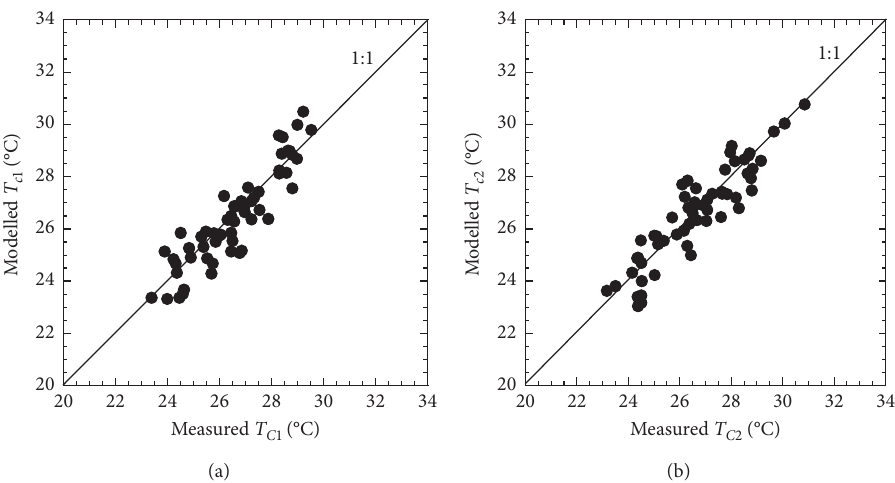
Figure 6: Comparisons between the measured and modelled upper layer canopy temperature ( T ( T c 2 ) (b) in the rice paddy field from August 5 to September 7,